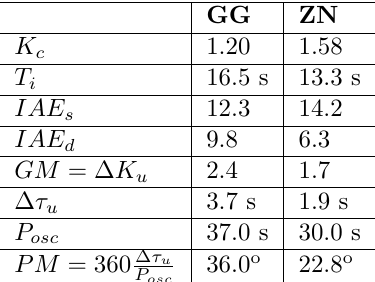
Figure 8: Temperature control system: Setpoint step response with Ziegler-Nichols